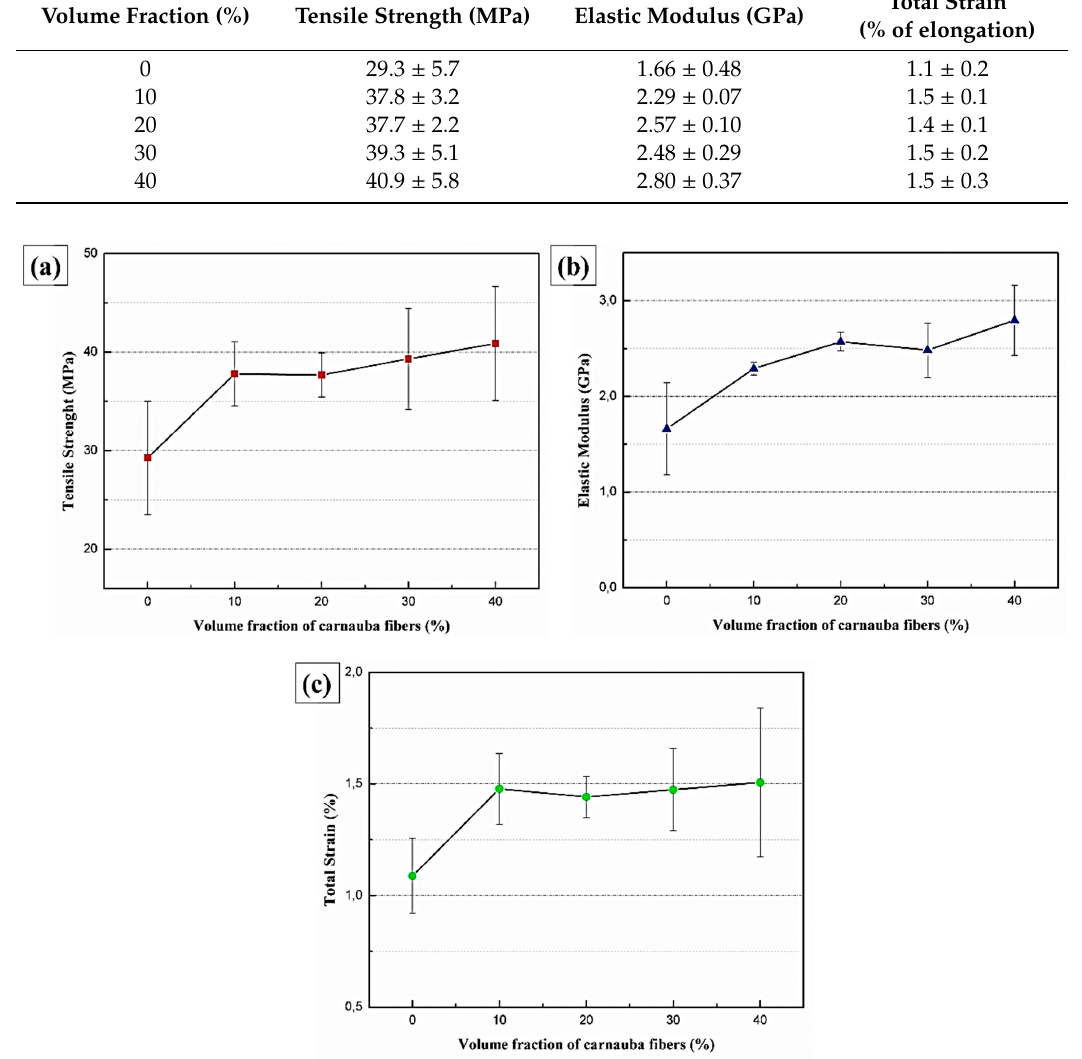
Figure 8. Mechanical properties as a function of the volume fraction for the neat epoxy resin and carnauba fibers reinforced epoxy composites. ( a ) Tensile strength, ( b ) elastic modulus, and ( c ) total strain.